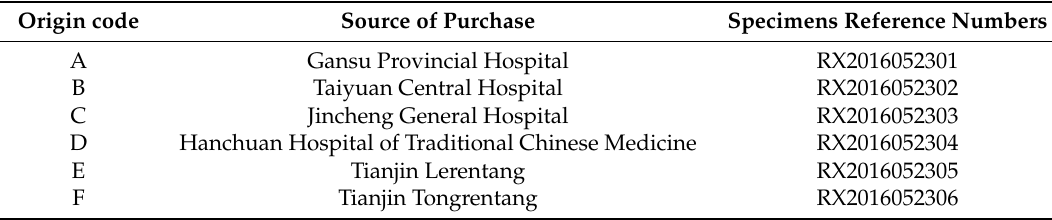
Table 6. Six batches of frankincense